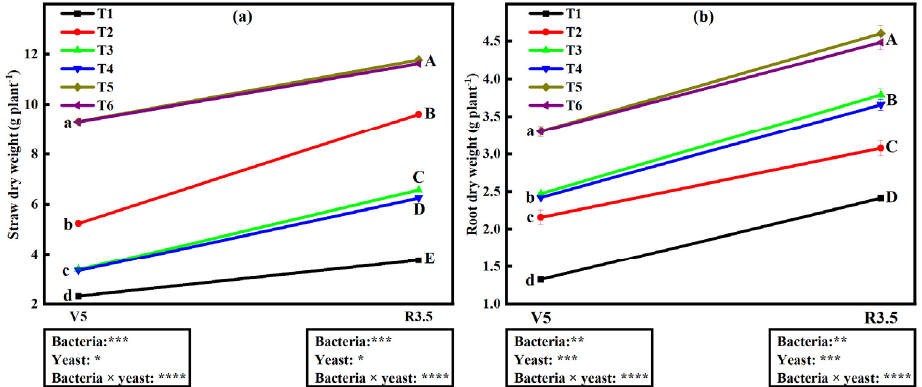
Figure 5. Measurements of ( a ) straw dry weight and ( b ) root dry weight of soybean straw under different microbial treatments at V 5 and R 8 physiological stages. Data (means ± SE, n = 5). Points with lowercase letters and uppercase letters denote V 5 stage and R 3.5 , respectively. p -values of two-way ANOVAs followed by different letters denote significant differences between treatments at p < 0.05 in the same stage according to Tukey’s HSD. p -values of two-way ANOVAs of bacteria, yeast, and their interaction (bacteria × yeast) are indicated: p < 0.05, *; p < 0.01, **; p < 0.001, ***; p < 0.0001, ****; ns, not significant. Treatments: non-inoculated soybeans (T1), soybean inoculated with B. japonicum (T2), S. cerevisiae (T3), S. exiguus (T4), B. japonicum × S. cerevisiae (T5), or B. japonicum × S. exiguus (T6).